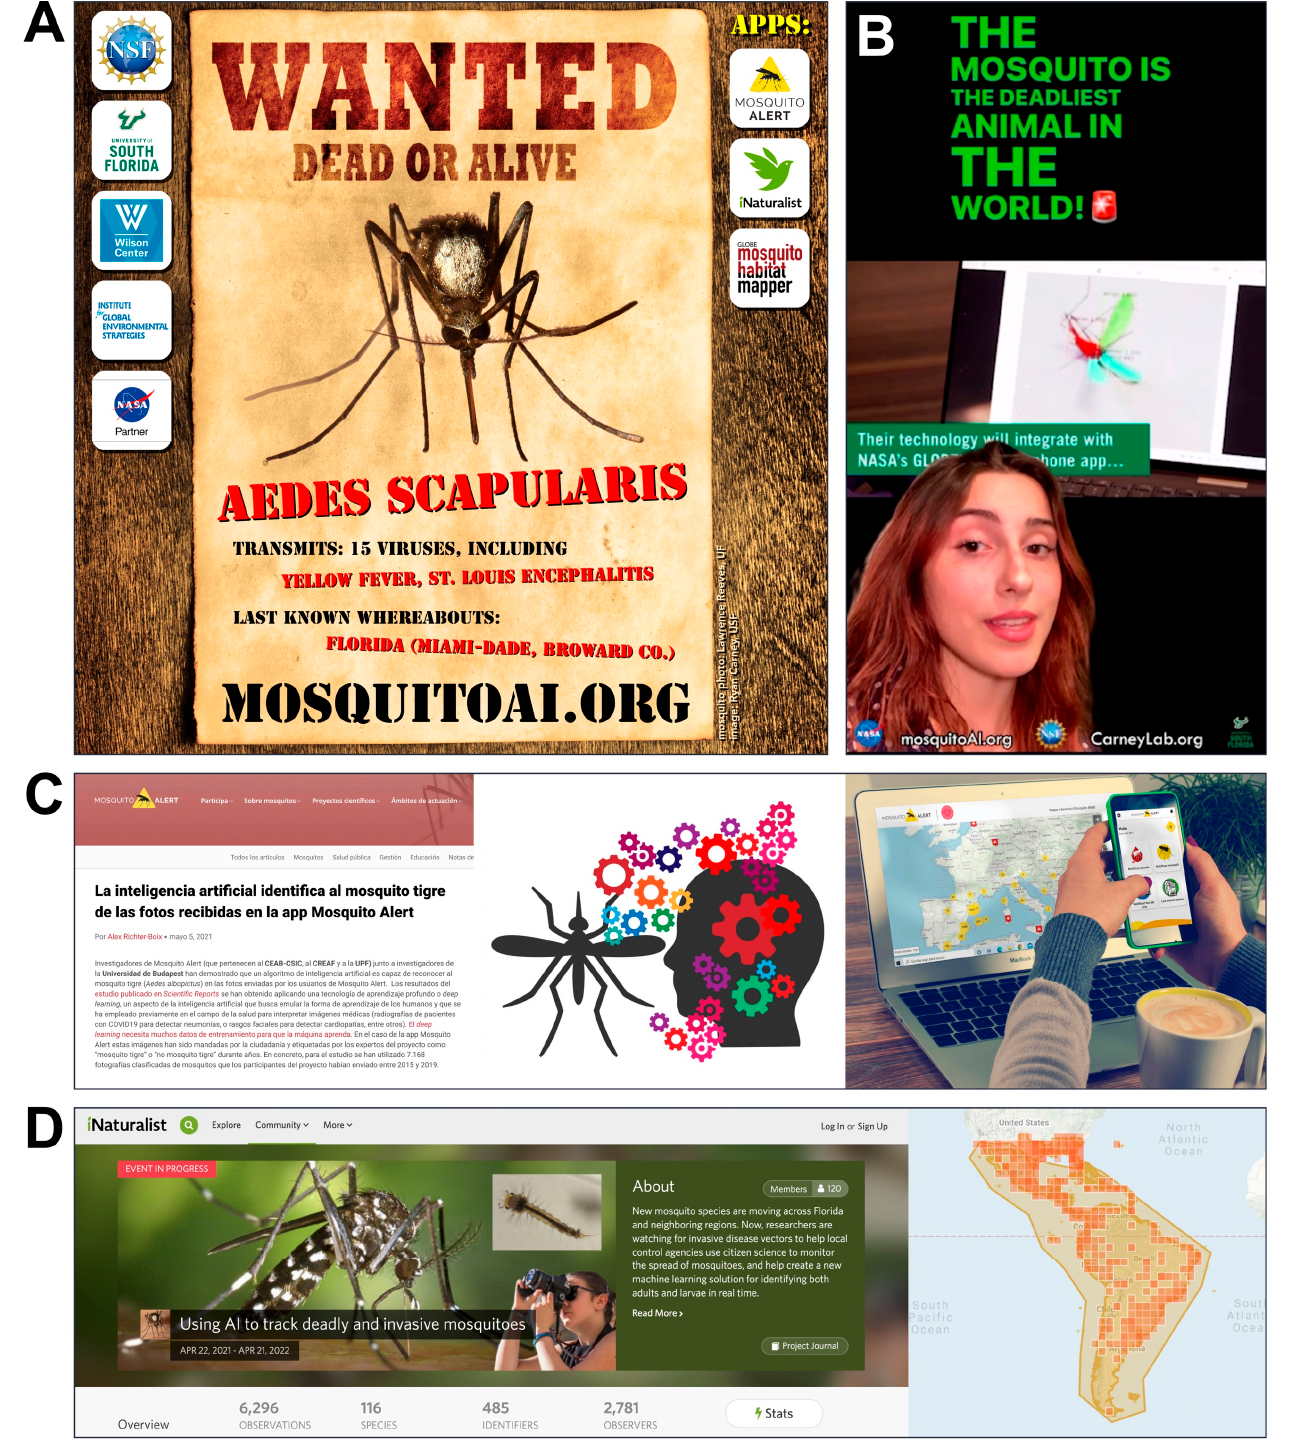
Figure 3 . Outreach materials from our citizen science campaigns. ( A ) “Wanted” poster of Aedes scapularis , an invasive vector species in Florida, displaying the diagnostic gold patch on the anterior scutum [35]. ( B ) Screenshot of video posted to NASA Earth’s Instagram account (insta- gram.com/reel/CSzbNMyluzg, accessed on 30 June 2022). ( C ) Screenshots of press release materials from Mosquito Alert campaigns. ( D ) Screenshots of iNaturalist project page header (left) and geo- graphic bounds (right), via campaign’s simplified URL mosquitoAI.org (accessed on 21 April 2022).